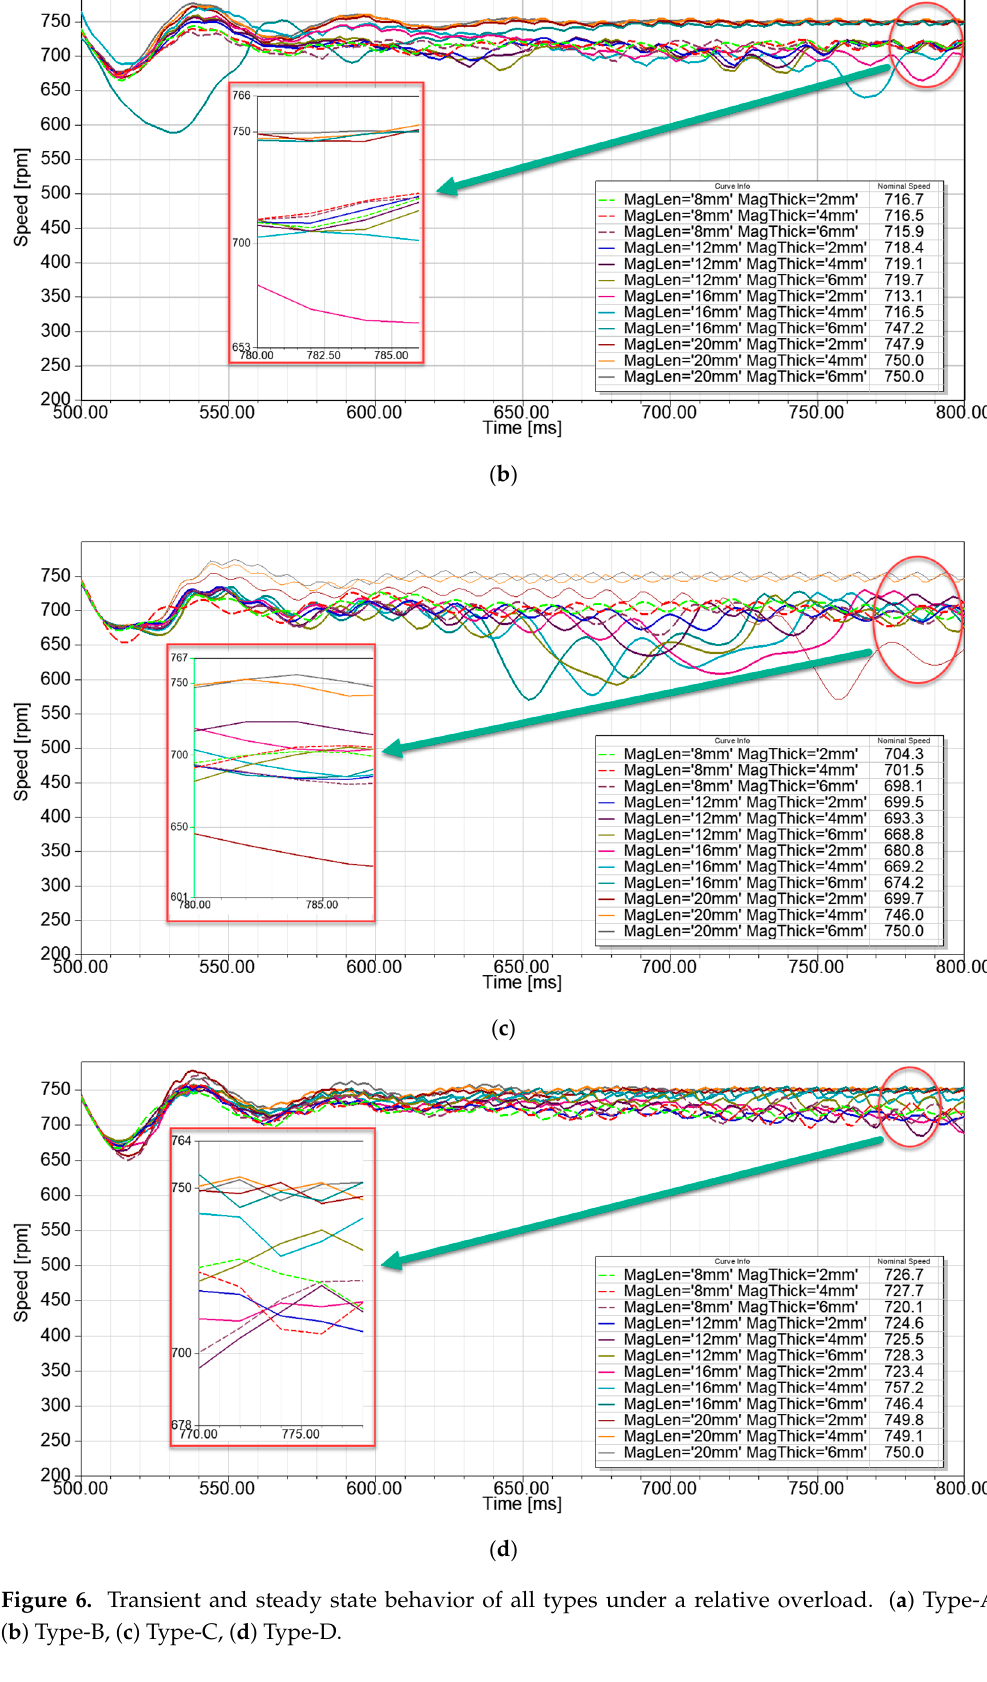
Figure 6. Transient and steady state behavior of all types under a relative overload. ( a ) Type-A, ( b ) Type-B, ( c ) Type-C, ( d ) Type-D.